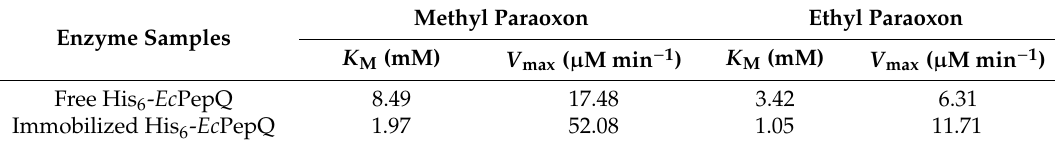
Table 1. Kinetic parameters of free and immobilized enzymes.